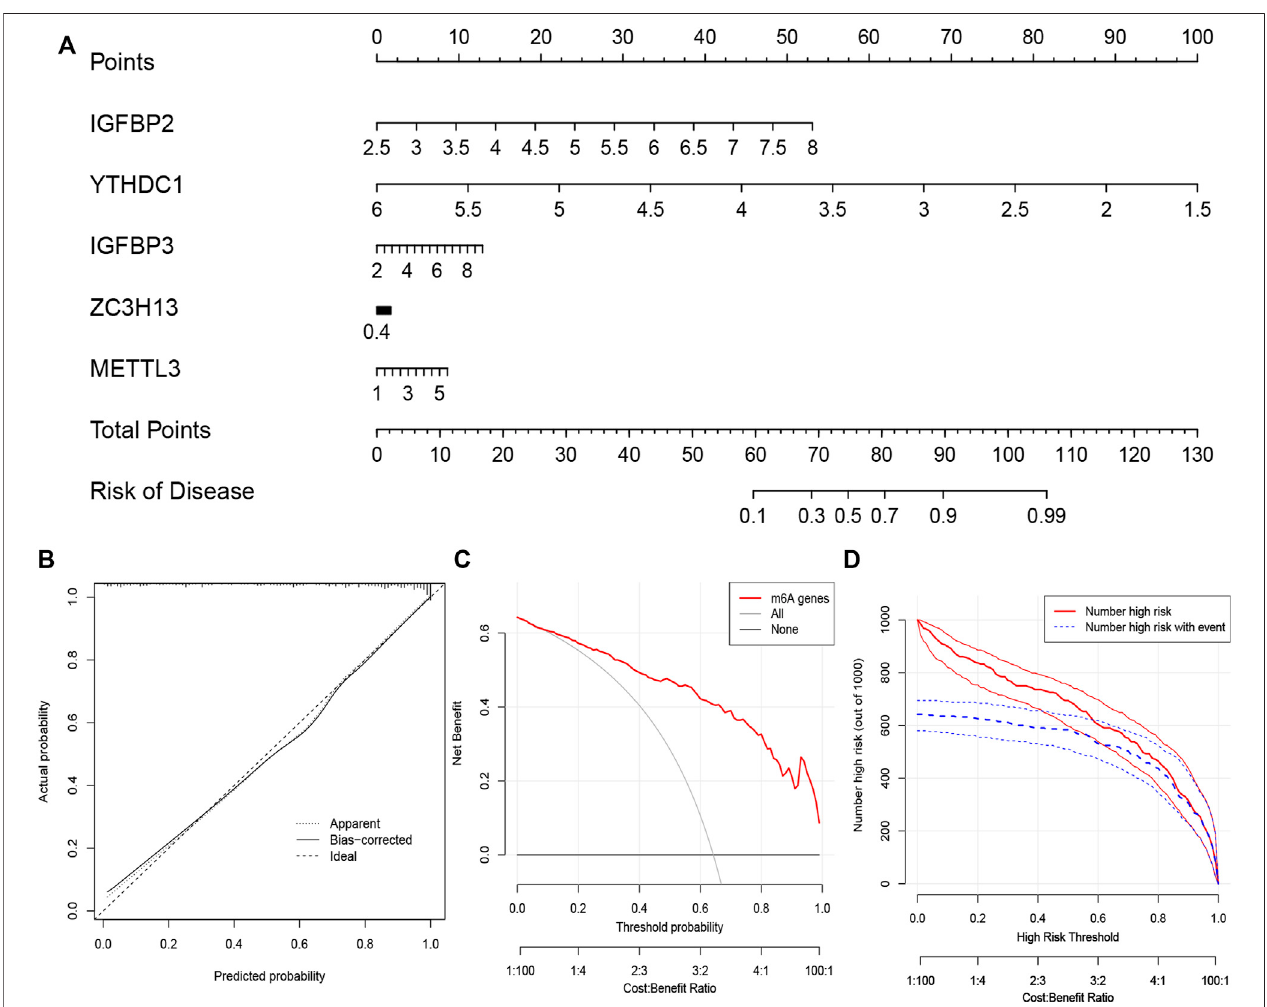
FIGURE 4 | The nomogram model construction (A) The prevalence was predicted according to gene score. Total points of 60 represented a prevalence of 10%, while 90 scores meant a prevalence of 90%. (B) Calibration curve was constructed to assess the accuracy of nomogram model (C) The construction of the decision curve. (D) Clinical impact curve based on the fi ve candidate RNA N6-methyladenosine regulators.